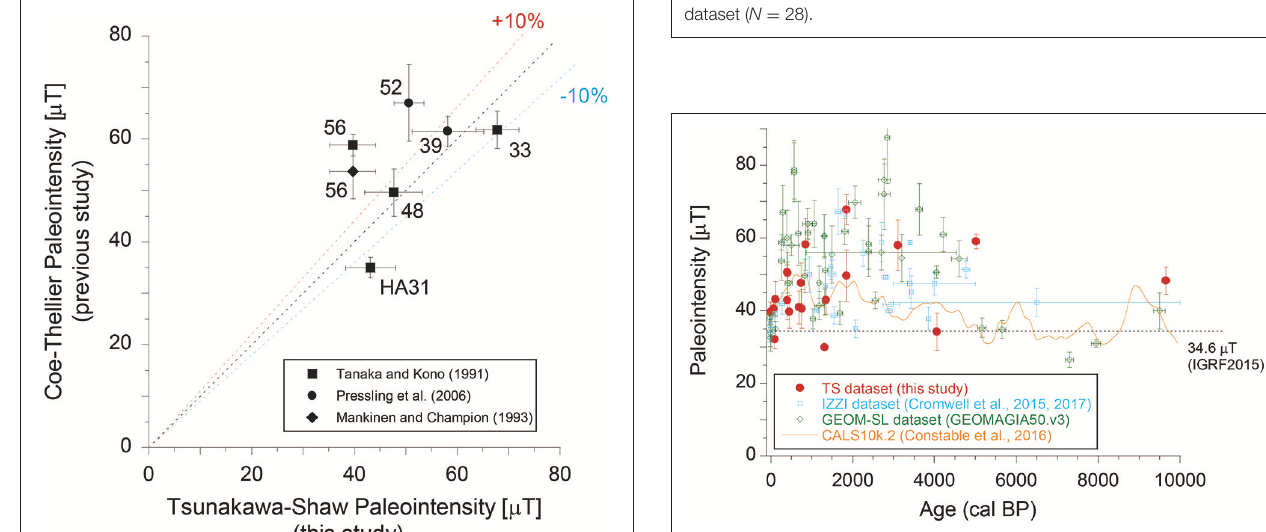
globe and this variation might be inferred as a global-scale dipolar phenomenon. Though the two variations do not appear to match with the global model of CALS10k.2 (Constable et al., 2016; Figure 8 ), the model is compiled with a dominance of sediment data (Constable et al., 2016) and is not thought to reflect possible rapid variations in